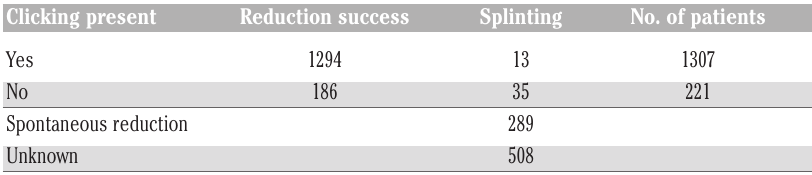
Table 1. Presence of clicking and reduction outcomes.